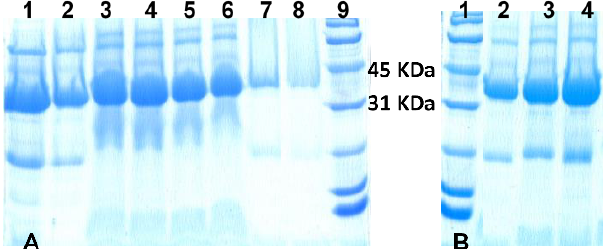
Figure 3. ( A ) 12% SDS-PAGE electrophoresis gel of (from right to left): ( 1 ) CaLB lipase extract, biocatalysts, ( 2 ) Lip@NH 2 -MIL-53(Al)-NaOH-1 h, ( 3 ) Lip@NH 2 -MIL-53(Al)-NaOH-3 h, ( 4 ) Lip@NH 2 -MIL-53(Al)-NaOH-24 h, ( 5 ) Lip@NH 2 -MIL-53(Al)-TEA-3 h, ( 6 ) Lip@NH 2 -MIL-53(Al)-TEA-24 h, ( 7 ) Lip#MIL-53(Al)-NaOH-3 h, ( 8 ) Lip#NH 2 -MIL-53(Al)-NaOH-3 h, ( 9 ) a protein marker. ( B ) 12% SDS-PAGE electrophoresis gel of (from right to left): ( 1 ) A protein marker, ( 2 ) Lip@NH 2 -MIL-53(Al)- NH 4 OH-3 h, ( 3 ) Lip@NH 2 -MIL-53(Al)-NH 4 OH-24 h, ( 4 ) CaLB lipase extract.